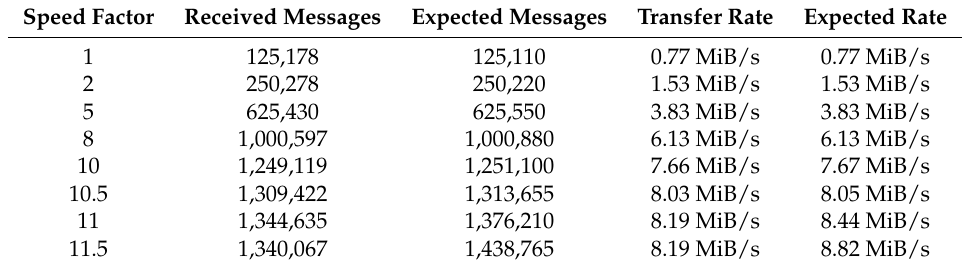
Table 3. Average transfer speed and number of messages received during a 10 second period. Each value is the average of 5 consecutive